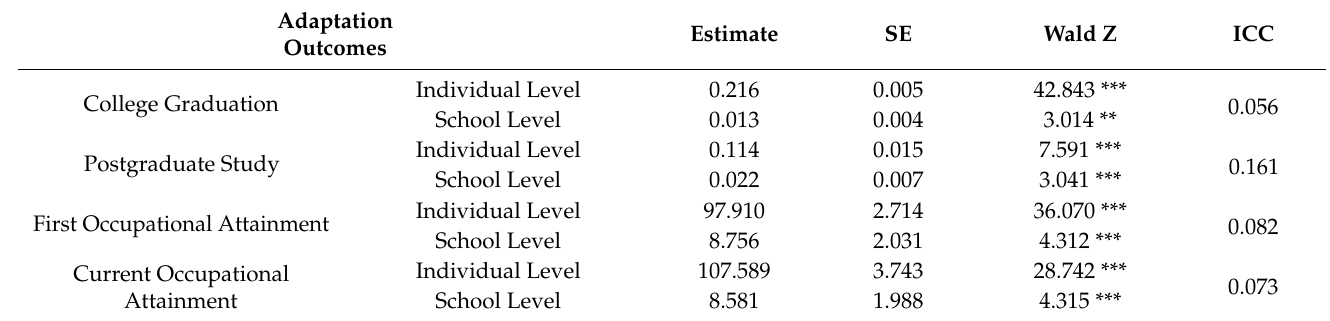
Table 3. Unconditional Modeling Immigrant Children’s Adaptation Outcomes in the Individual and School